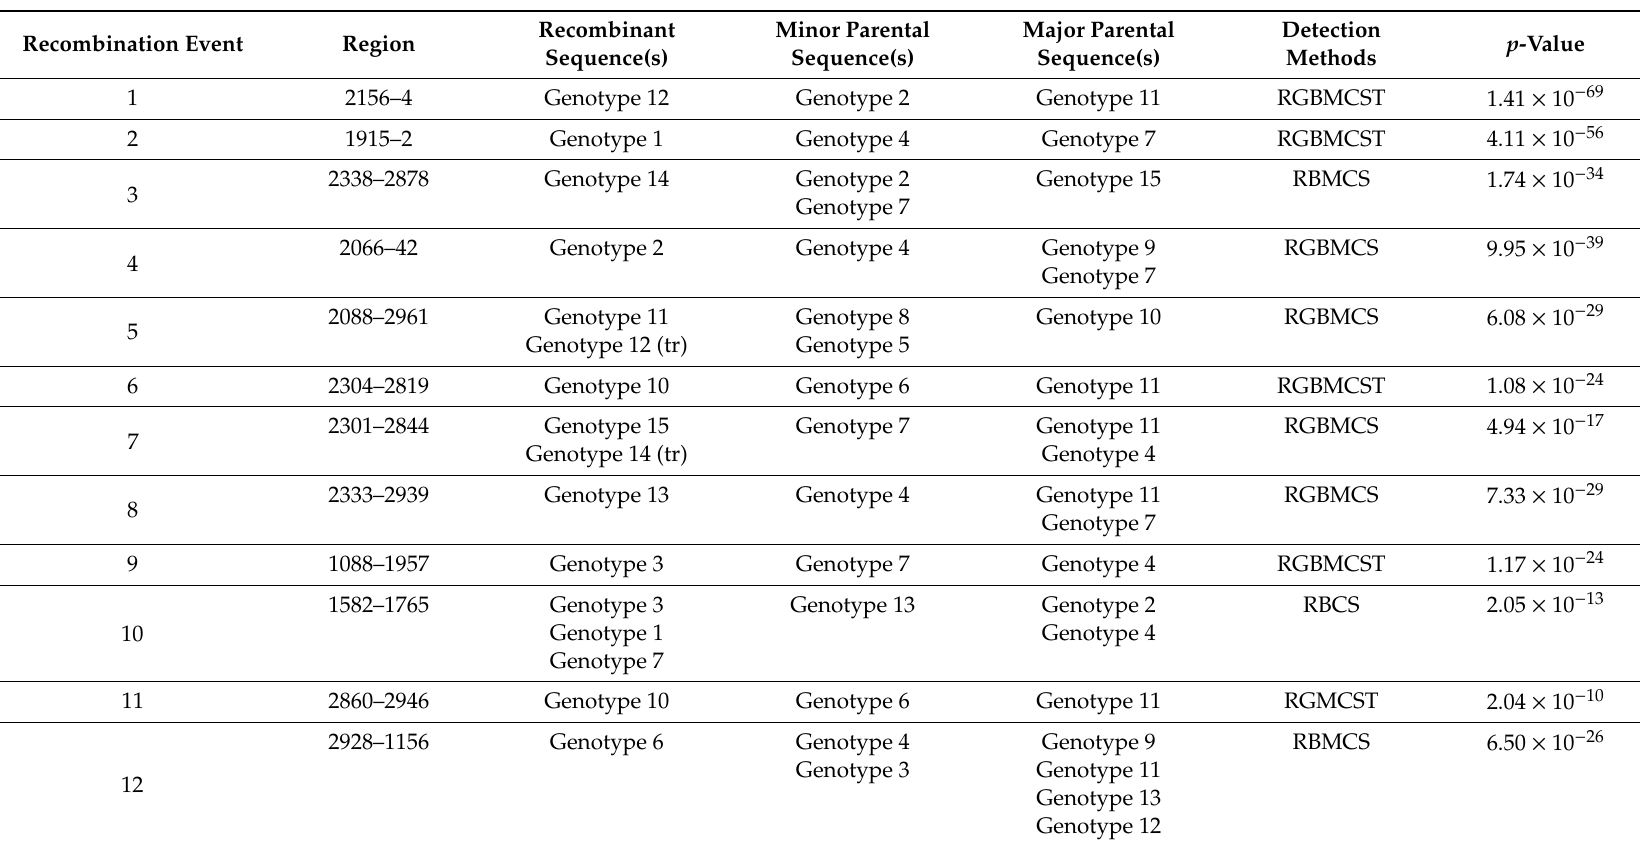
Table 2. Summary of the 23 events of recombination detected by RDP4. The methods used to detect recombination are RDP (R) GENCONV (G), BOOTSCAN (B), MAXCHI (M), CHIMERA (C), SISCAN (S) and 3SEQ (T). The method with the highest p -value for each recombination event is bolded. Sites where the actual breakpoint is undetermined are marked with *. (tr) denotes trace of recombination